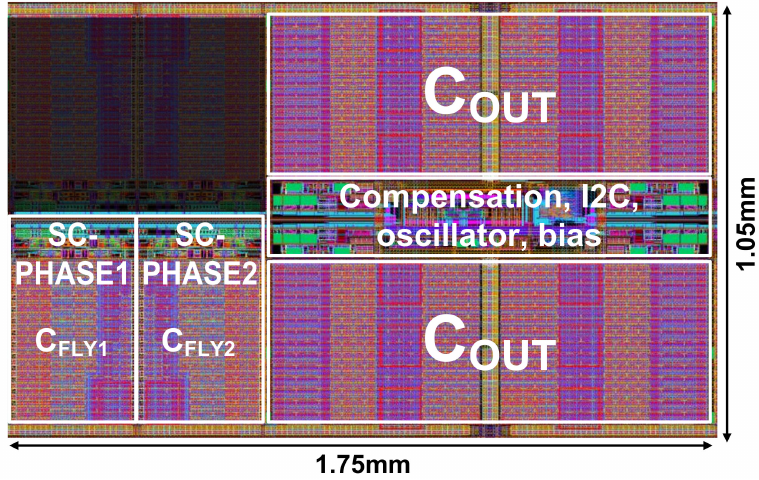
Figure 7. Chip layout of the proposed DC-DC